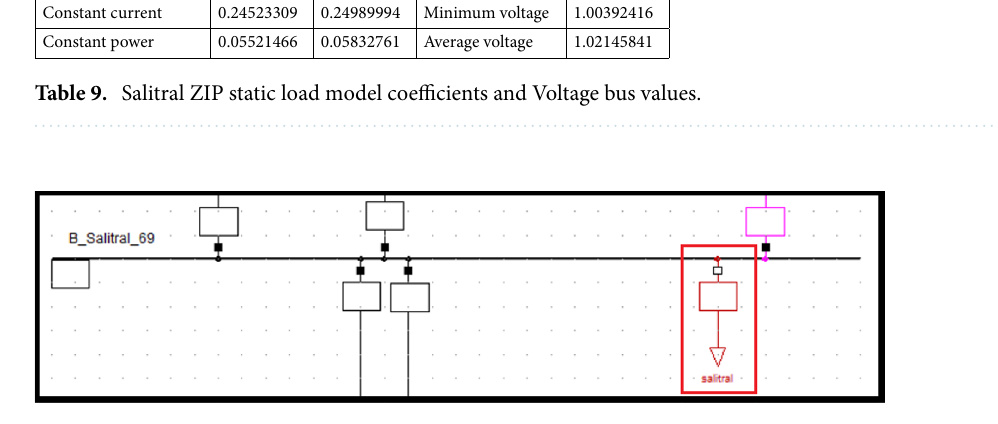
Figure 8. Salitral static (general) load model representation.